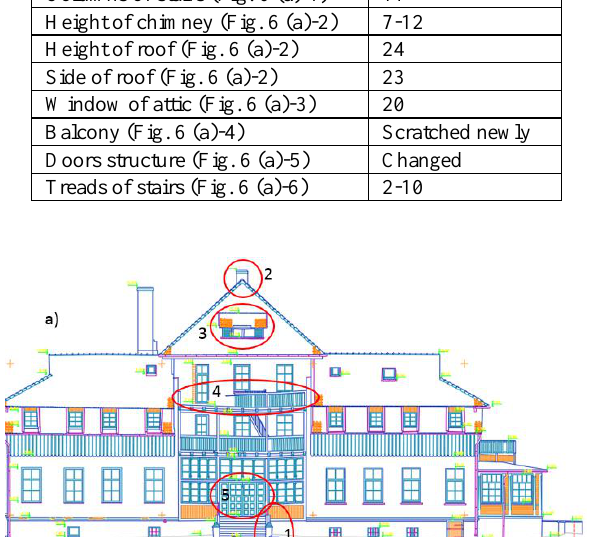
Figure 7. Northern façade of the building: a) surveyors 2D drafting; b) architects 2D